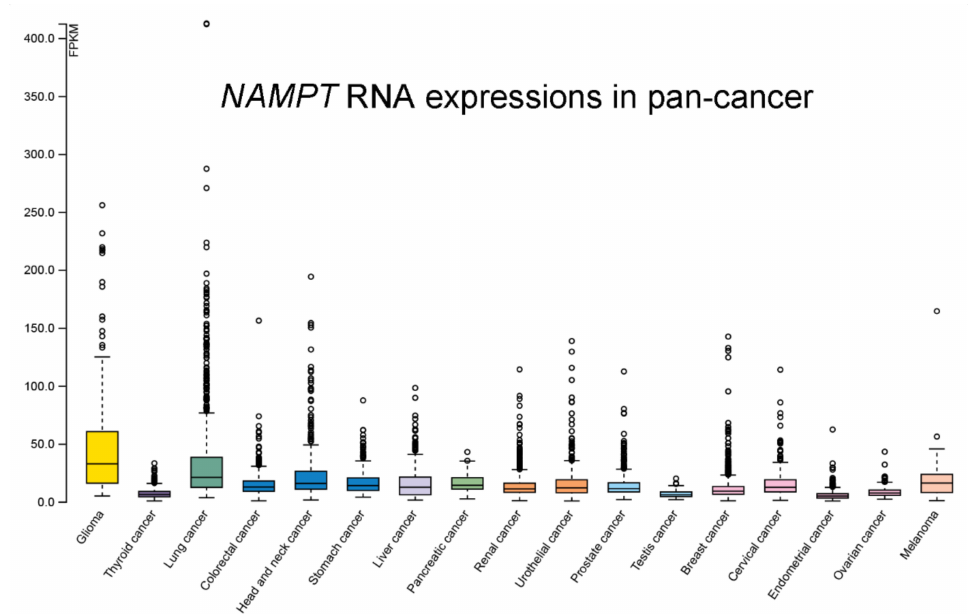
Figure 5. NAMPT RNA-seq data for 17 cancer types from TCGA were analyzed and reported as the median number of fragments per kilobase of exon per million reads (FPKM). Normal distribution across the dataset is represented by box plots, shown as the median, 25th, and 75th percentiles. The points represented the data of outliers if the expression levels are below or above 1.5 times the interquartile range. The data for the analyses were retrieved from HPA database (https://www. proteinatlas.org/, accessed on 28 February